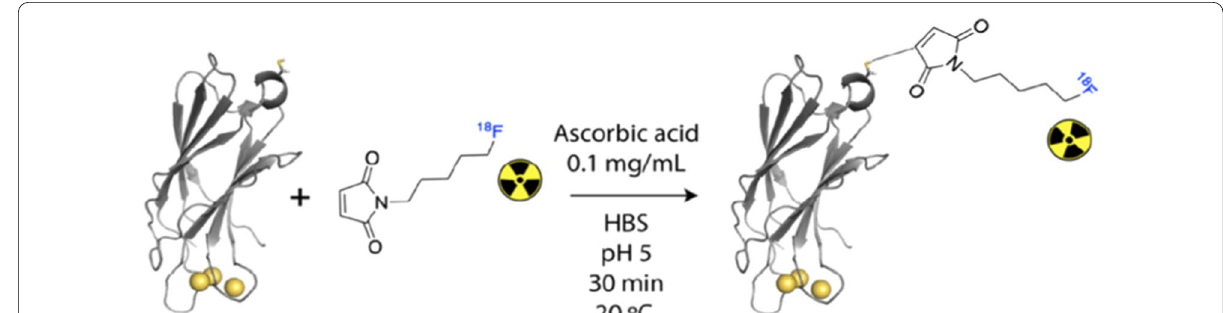
Fig. 1 Radiochemical labeling of C2Am, using N‑(5‑[ 18 F]fluoropentyl) maleimide, to yield 18 F‑C2Am. The rapid Michael addition reaction takes place under mild conditions (20 °C, pH5, HBS buffer) in the presence of ascorbic acid. The secondary structure of C2Am is shown, highlighting the single cysteine residue (top, yellow) and the active site (lower) containing three calcium ions (yellow